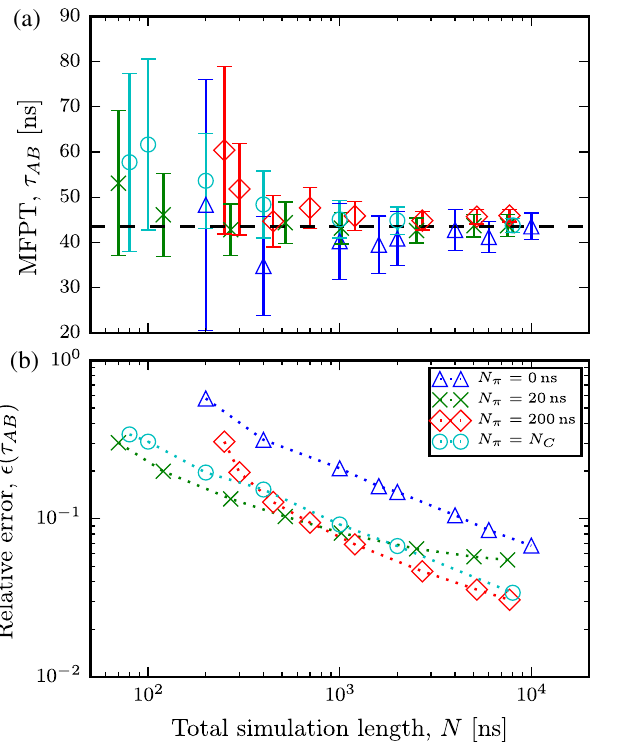
FIG. 6. Mean and standard error of mean first passage time (MFPT) τ AB , total simulation effort N , for alanine-dipeptide MSM on the ϕ , ψ dihedral angles. The mean first-passage time τ C α AB of the 5 to L transition is used as an observable for a rare- event process. (a) Convergence of the mean value is shown for a small number of long chains starting in the C 5 region (blue), an ensemble of short chains starting in the α L region combined with different amounts of umbrella sampling simulations (green, red, light blue). The correct value of the C 5 to α L transition, τ 43 ns, can be obtained for a total simulation effort of AB ¼ N ¼ 70 ns when short “ down-hill ” simulations are used in combination with umbrella sampling data. (b) The standard error shows almost 1 order of magnitude speed-up when estimating the kinetic characteristic of a rare event τ AB using short trajecto- ries in combination with umbrella sampling simulations com- pared to using long trajectories and no additional information about the equilibrium